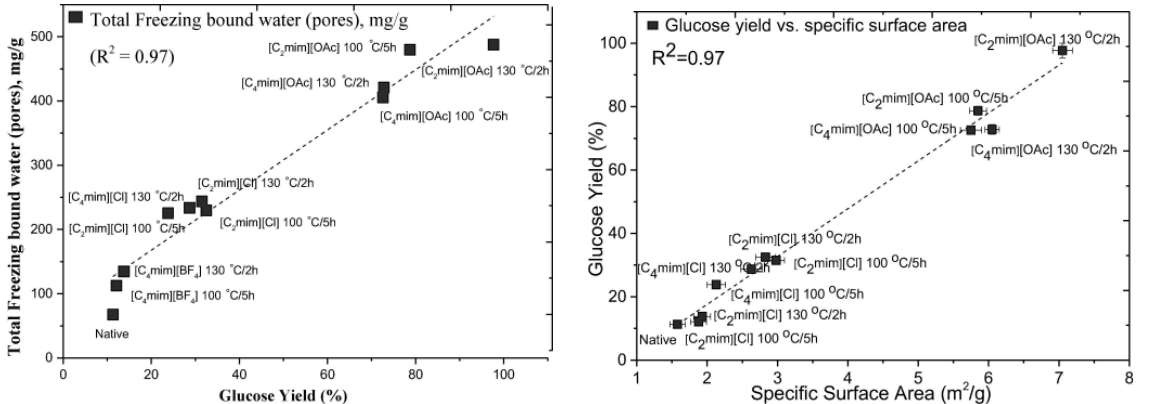
Figure 2. Correlation between porosity ( left ) and surface area ( right ) of the pretreated cellulosic biomass vs. glucose yield (reprinted with permission from [29]. Copyright © 2018, Elsevier).